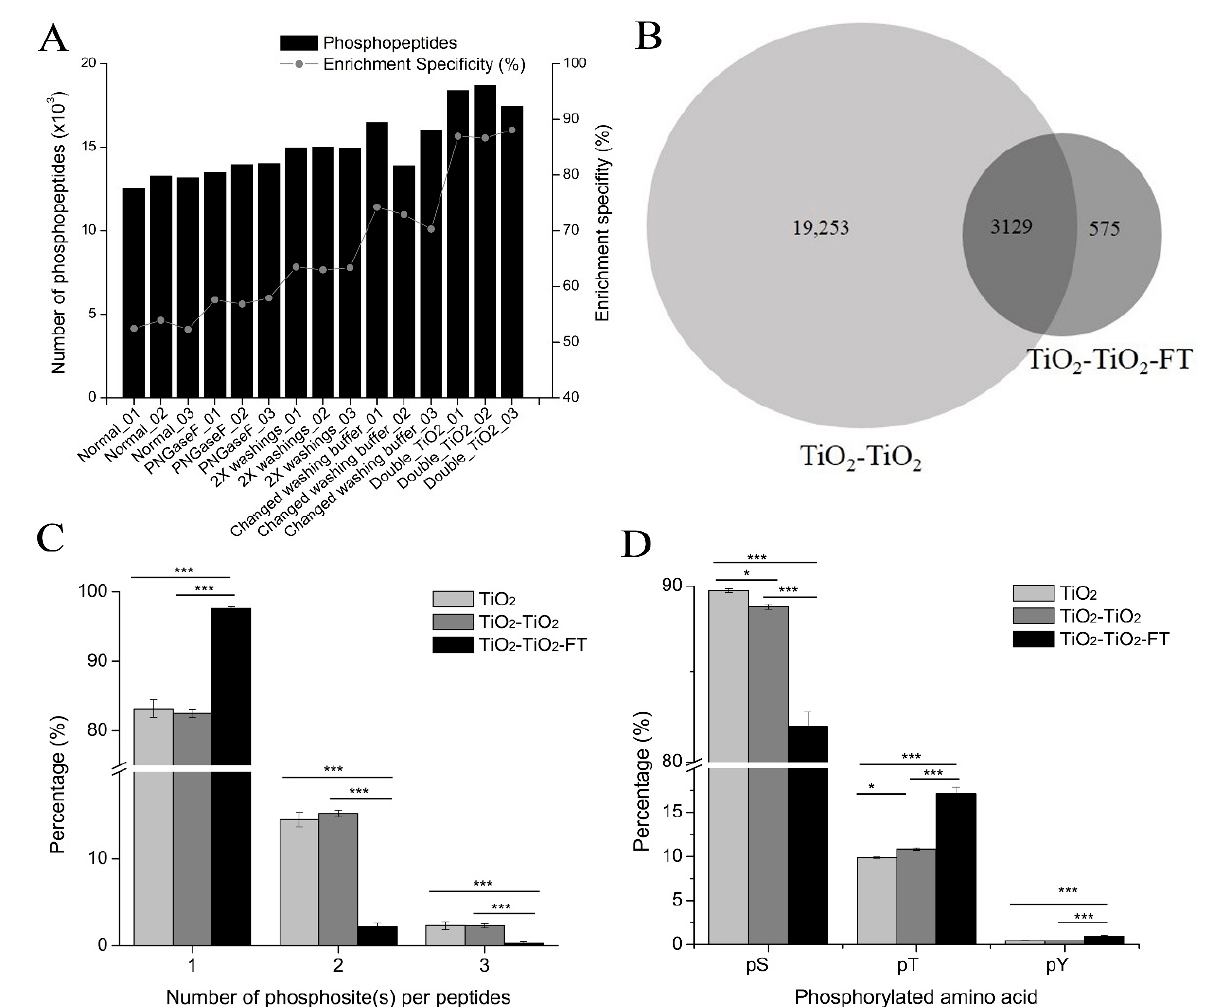
Figure 4. Improved phosphopeptide enrichment protocols with TiO 2 using glycolic acid. ( A ) Pro